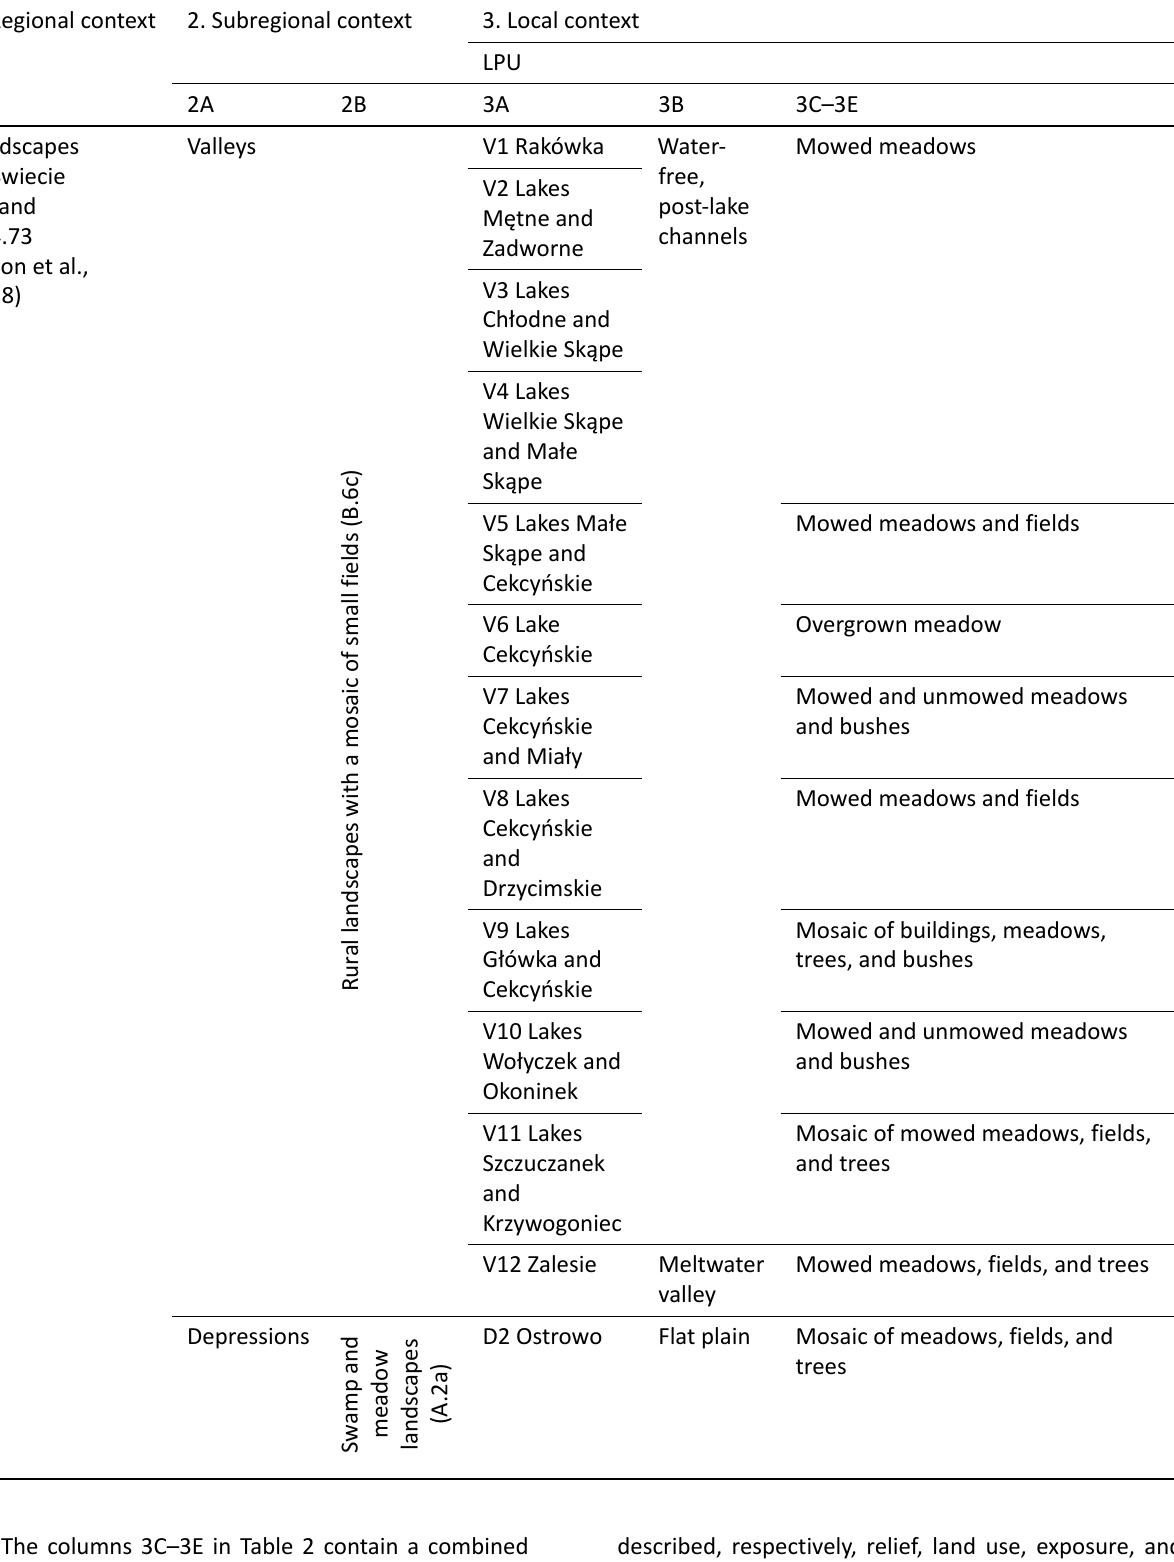
Table 2. (Cont.) Classification of the landscape units of the study area with integrated description of subunits. 1. Regional